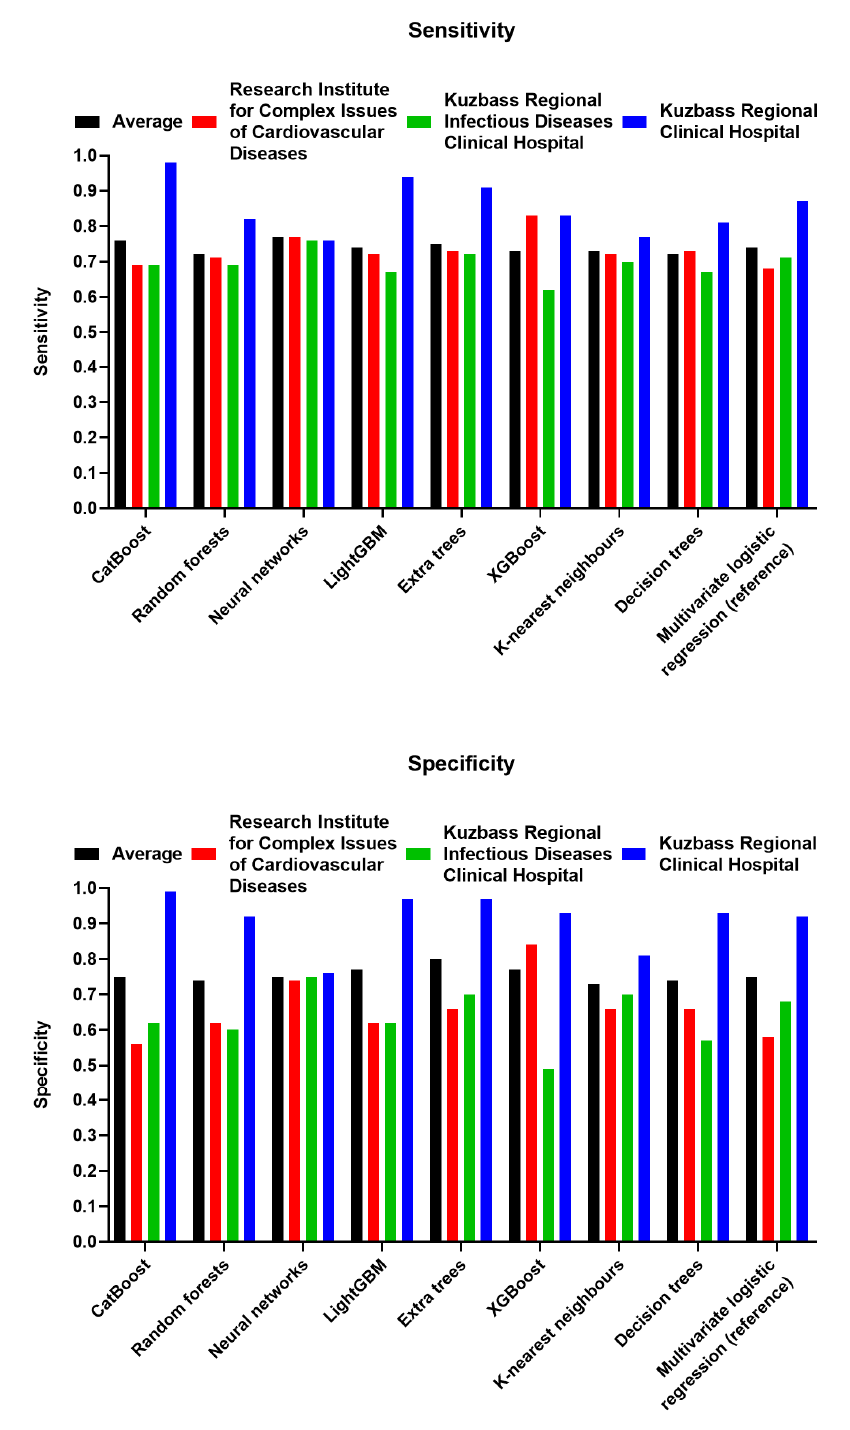
Figure 5. Sensitivity ( top ) and specificity ( bottom ) of the employed ML algorithms. Black color: average value across three centers, red color: Research Institute for Complex Issues of Cardiovascular Diseases ( n = 100); green color: Kuzbass Regional Infectious Diseases Clinical Hospital ( n = 106); blue color: Kuzbass Regional Clinical Hospital ( n = 144).